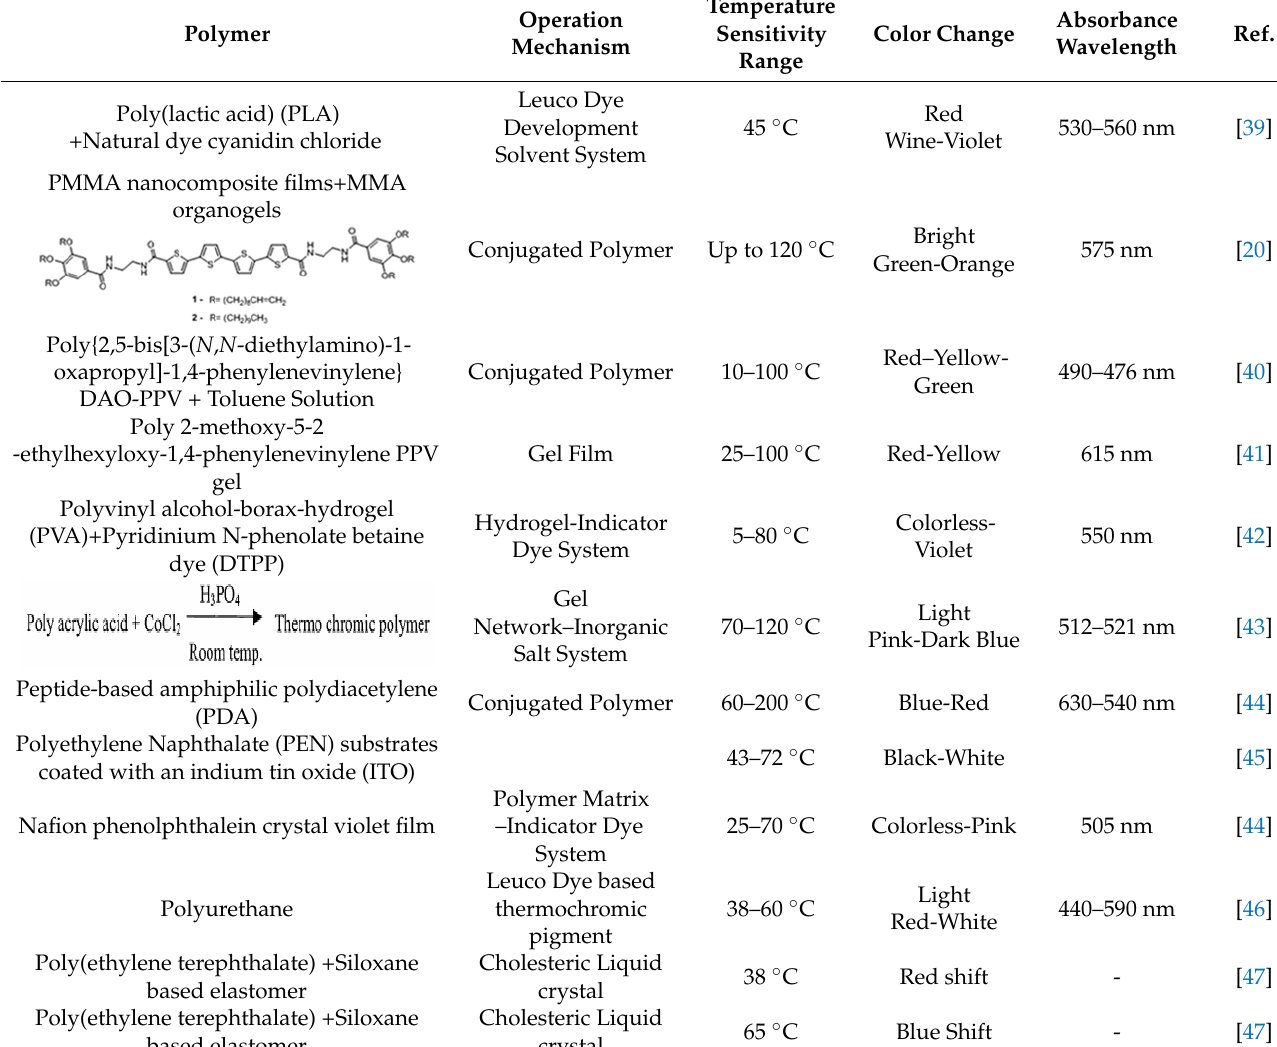
Table 2. Summary of thermochromic polymeric materials and their properties.